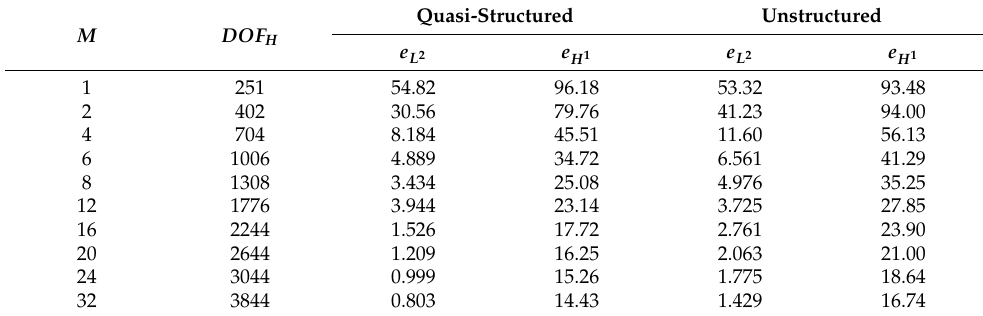
Table A3. Parabolic problem. Case 2 (non-homogeneous boundary conditions). Unstructured coarse grids. Relative L 2 and H 1 error in %. DOF h =